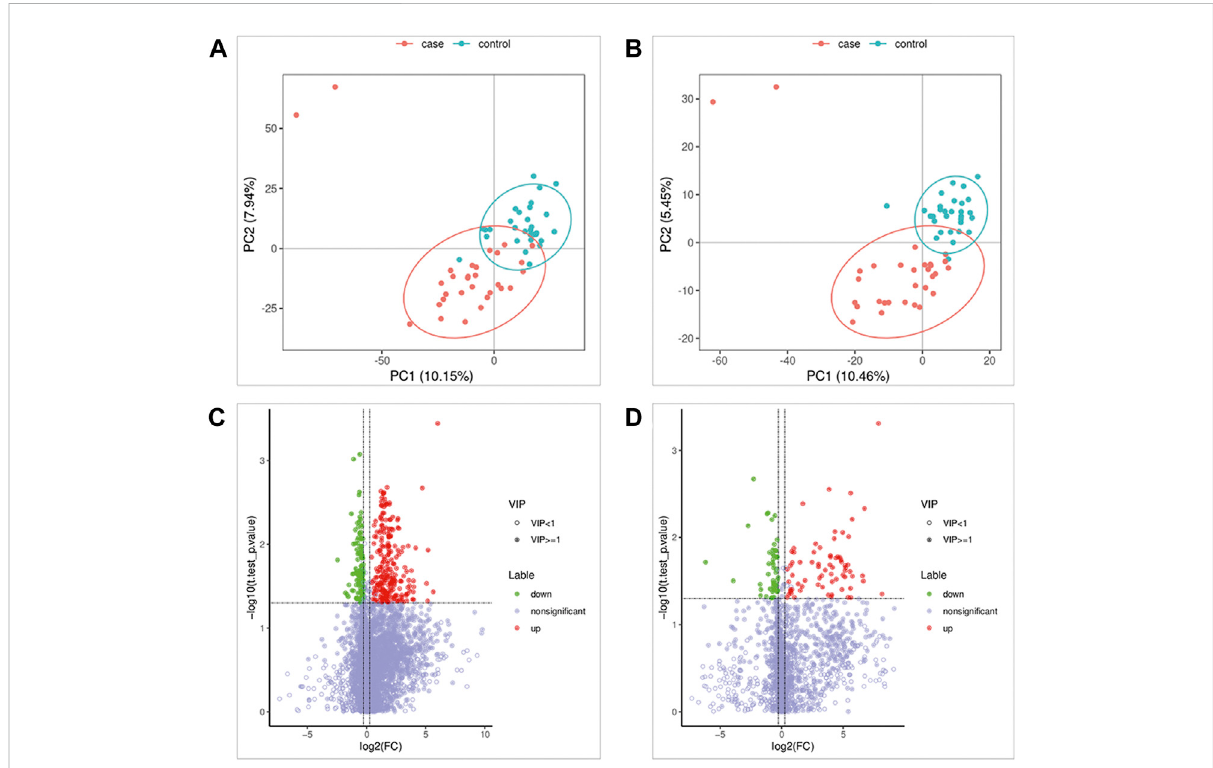
FIGURE 1 Metabolomics Analysis. (A,B) Partial least squares-discriminant analysis score scatter plots of the two groups. (C,D) Volcano map of differential metabolites. Green is the downregulated differential metabolite (labeled green), red is the upregulated differential metabolite (labeled red), and metabolites without differences are labeled purple ‒